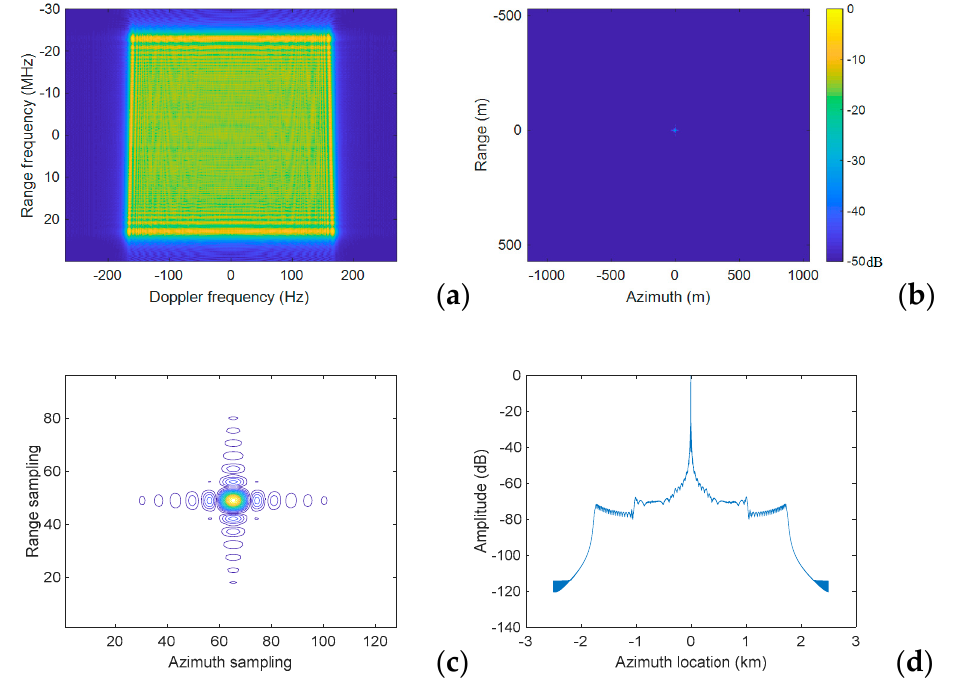
Figure 5. ImagingresultsofthestationarytargetinazimuthmultichannelGEO-SA-BiSAR.( a )Reconstructed two-dimensionspectrum.( b )Thefocusedpointtarget.( c )Contourplotsofthepointtarget.( d )Themaximum azimuth projection